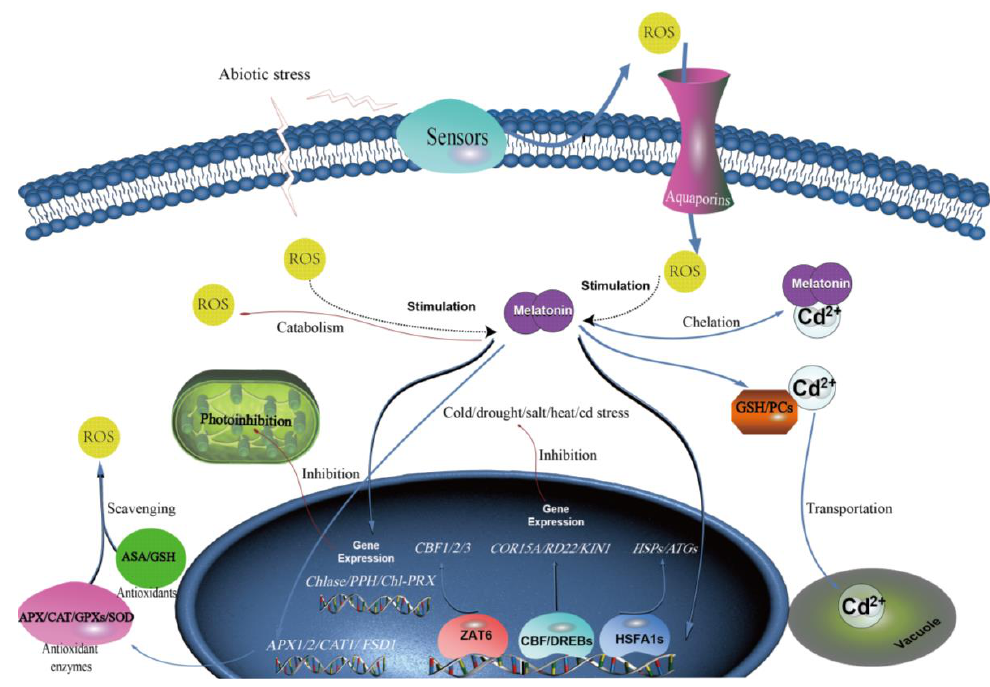
Figure 2. Melatonin-mediated abiotic stress response in plants. Abbreviation: ROS, reactive oxygen species; GSH, glutathione; PCs, phytochelatins; Cd, cadmium; SOD, superoxide dismutase; APX, ascorbate peroxidase; CAT, catalase; GPX, glutathione peroxidase; ASA, antioxidants ascorbic acid; GSH, glutathione. Dotted arrows represent the hypothetical pathway.